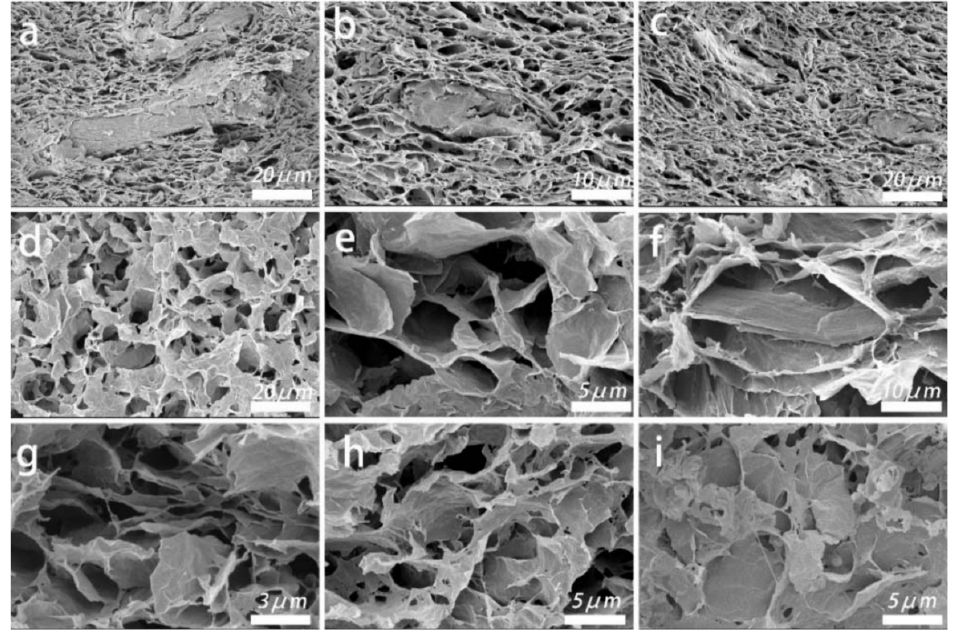
Figure 1. SEM images of ( a ) GA-MCC-3 aerogel, ( b ) GA-MCC-4 aerogel, ( c ) GA-MCC-5 aerogel, ( d , e ) GA aerogel in different magnifications, ( f , i ) GA-MCC-1 aerogel in different magnifications, ( g , h ) GA-MCC-2 aerogel in different